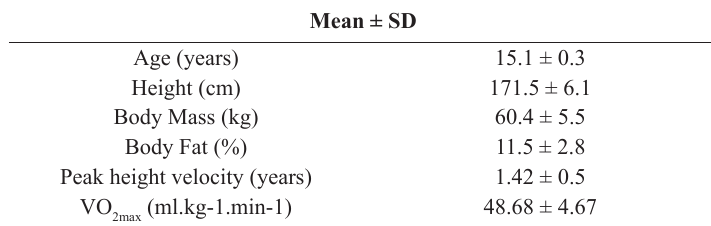
Table 1. Sample characteristics expressed in mean ± sd of age, height, body mass, body fat, peak height velocity and